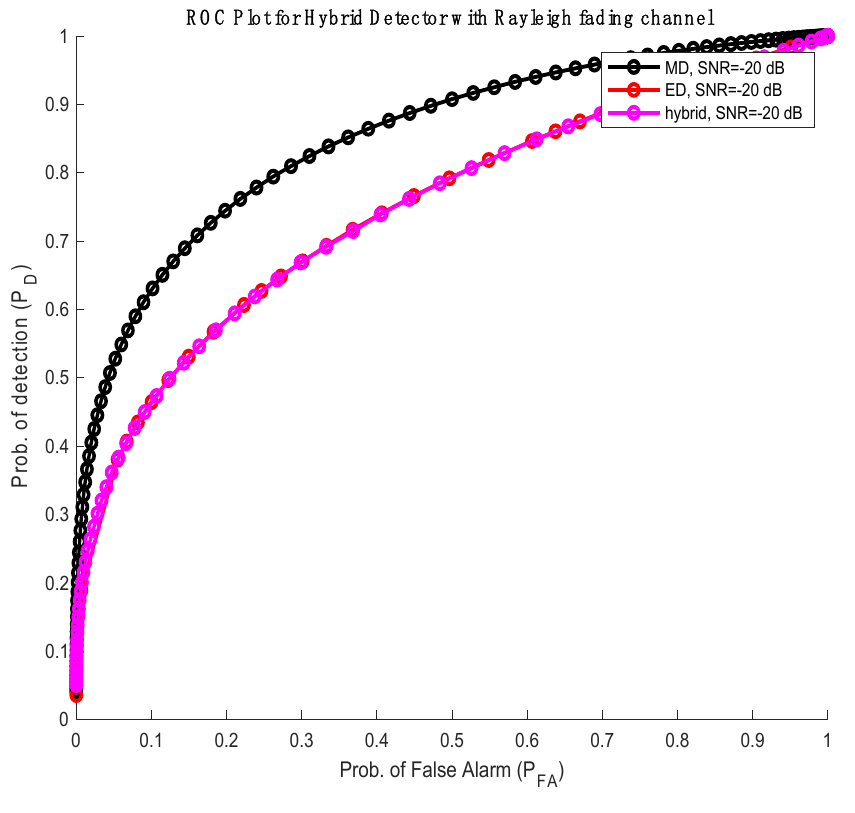
Figure 4. Hybrid detector under non CSS for case 1.